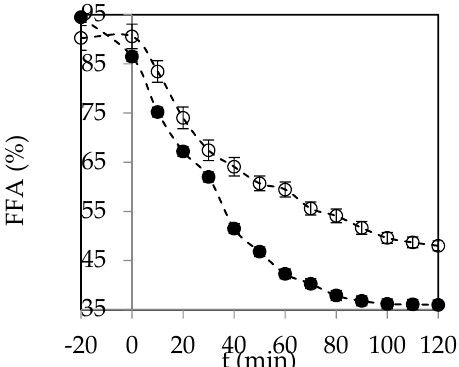
Figure 2. Esterification of linoleic acid with 20% excess glycerol over SnCl 2 ∙ 2H 2 O ( ● ) or biocatalyst ( ○ ) at 160 °C for 120 min (mean ± SD, n = 2).